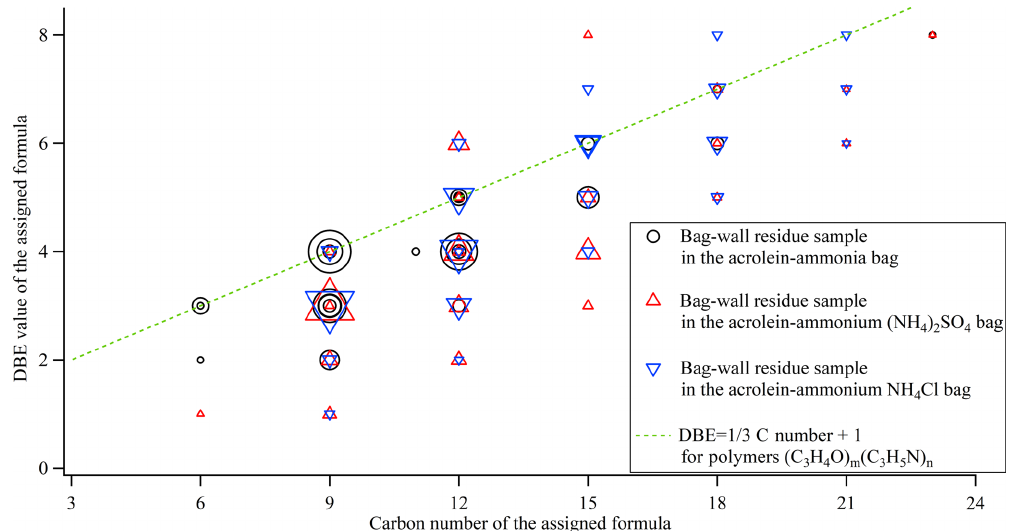
Figure 4. The DBE values versus the carbon number of the assigned formulae for the top 30 peaks in each mass spectrum in Fig. 3. The marker size is proportional to the HRMS peak